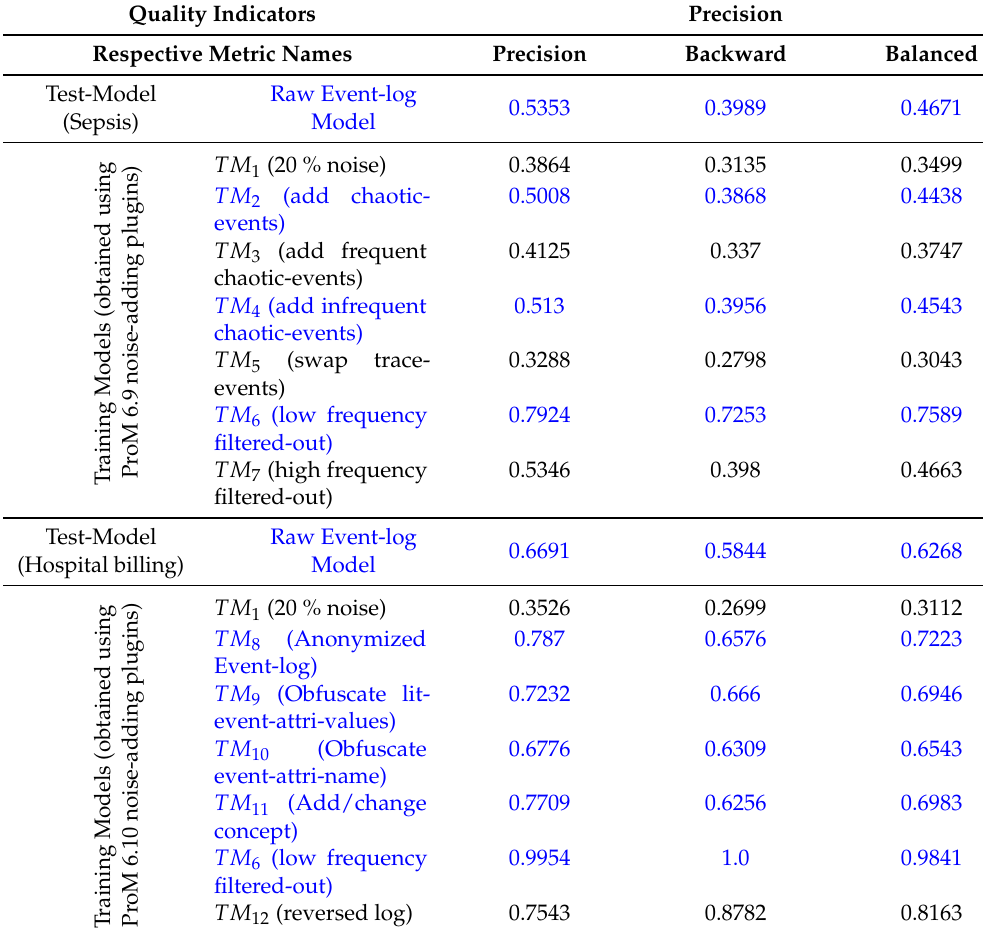
Table 2. ProM experiments results for the 2 test models and 12 training models using noise-adding plugins